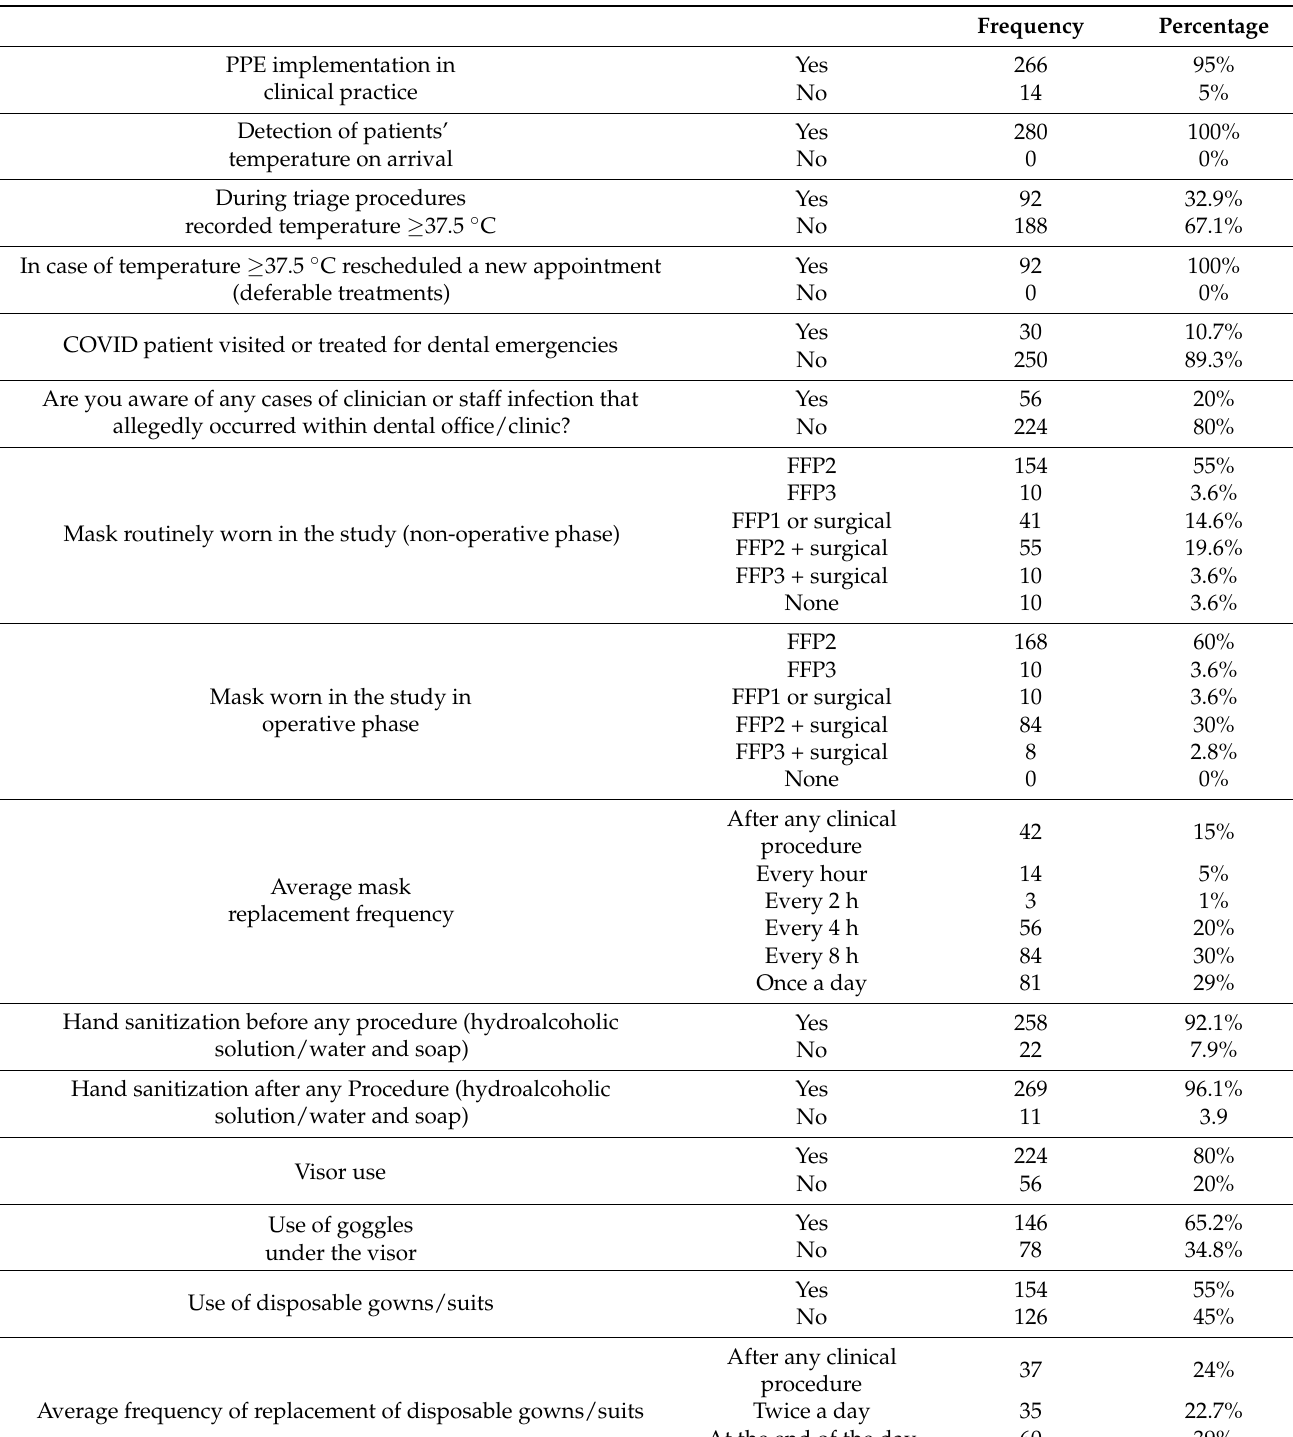
Table 2. Measures implemented and devices used daily in dental clinical practice to prevent SARS- CoV-2